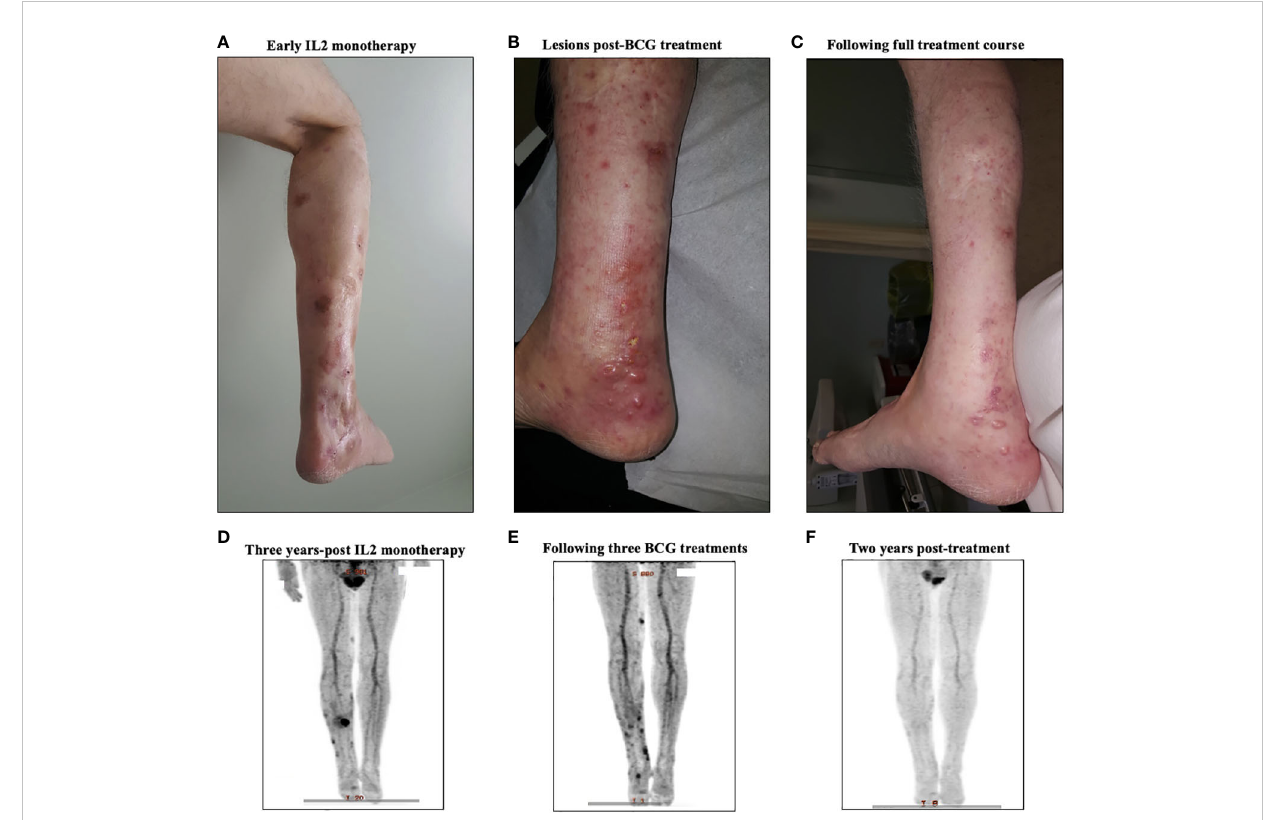
FIGURE 4 A representative case from a complete responder to intralesional IL-2 and BCG therapy. (A) Representative images of the treated lesion throughout IL-2 monotherapy treatment course. (B) PET-CT scan three years into IL-2 monotherapy showing new uptake among cutaneous lesions, signaling disease progression. (C) Representative image of the treated lesion following IL-2 and BCG treatment. (D) PET-CT scan after three BCG treatments showing regression of main lesions radiographically with new FDG uptake in distal lesions. (E) Representative image of the area after treatment, showing clinical resolution of BCG ulcers and in-transit metastasis. (F) Surveillance PET-CT two years post-treatment, showing no evidence of